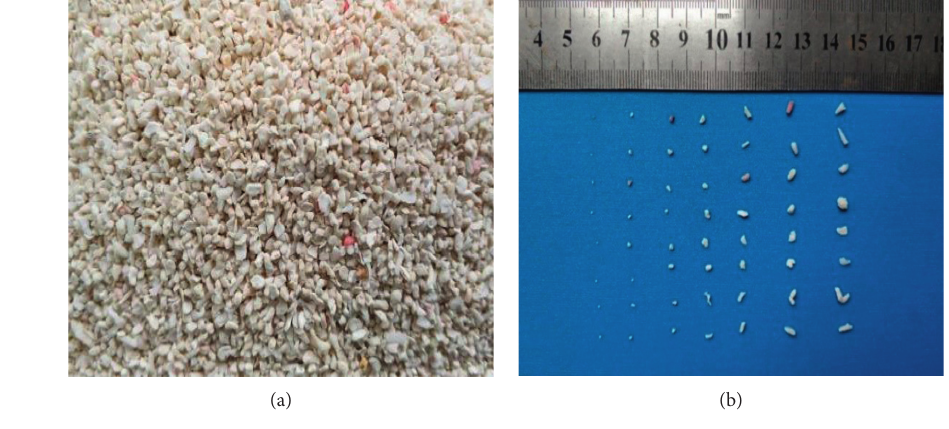
Figure 1: Specimens of calcareous sands.